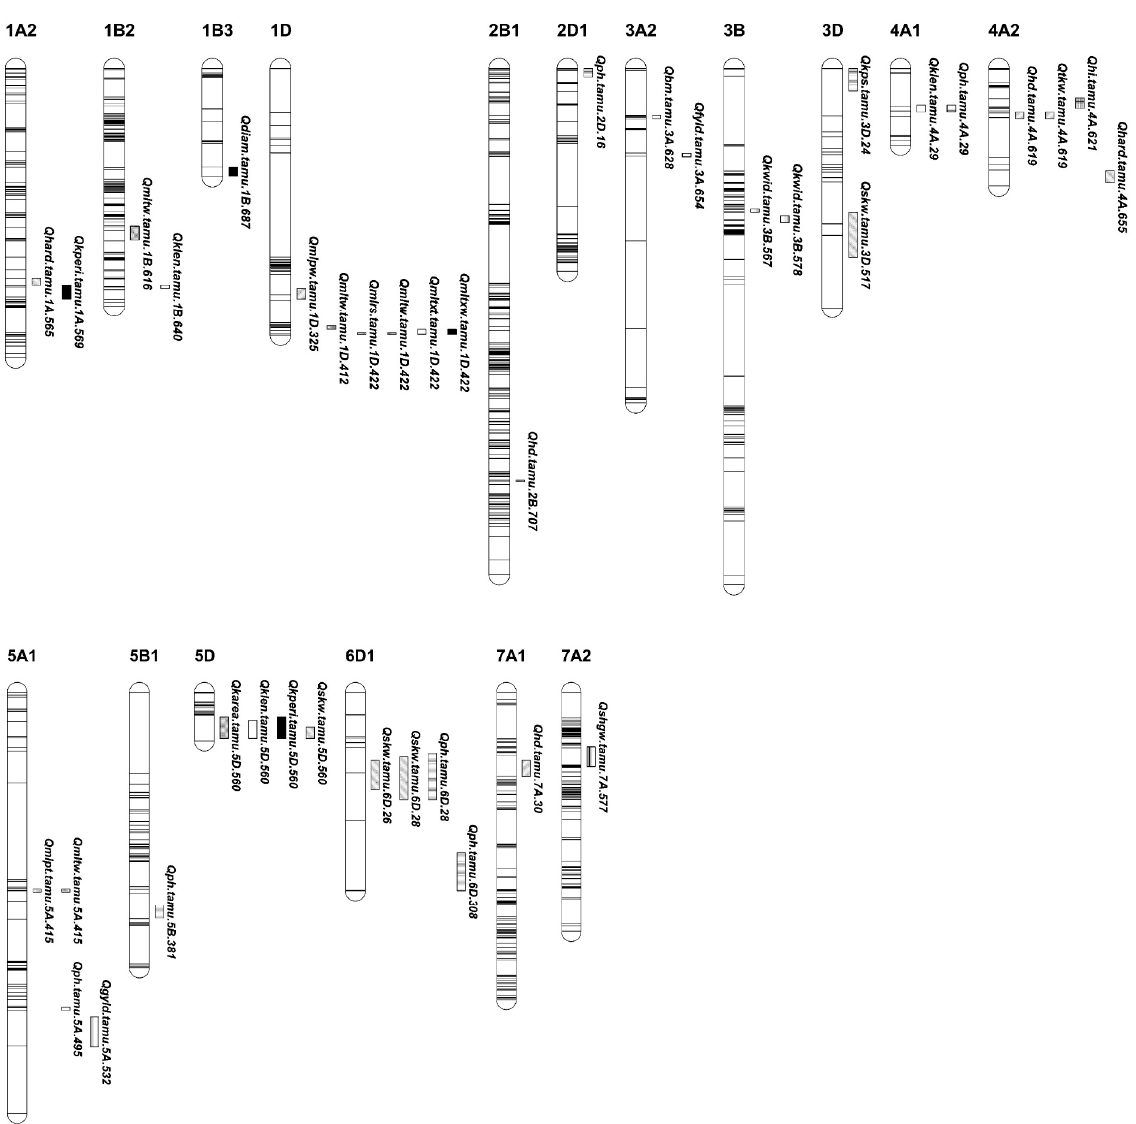
Figure 1. Genetic maps highlighting the positions of QTLs for end-use quality, agronomical, yield components, and kernel-related traits from the individual (IE), across multiple (MET) and combined BLUPs of the environments (COMB) in TAM 111 × TX05A001822 RIL population. Horizontal stripes inside a chromosome or linkage group represent the markers. Traits: hardness index (HARD), kernel diameter (DIAM), single kernel weight (SKW), flour yield (FYLD), flour protein at 14% moisture (PROT), flour ash at 14% moisture (ASH), midline peak time (MLPT), midline peak value (MLPV), midline peak width (MLPW), midline right slope (MLRS), midline tail width MLTW, midline time X time (MLTXT), midline time X width (MLTXW), grain yield (YLD), plant height (PH), days to heading in Julian Calendar from 1 January (HD), dry biomass from hand harvested 0.5 m long inner row sample (BM), grain weight from BM as hand harvested dry grain weight (BMYLD), harvest index (HI), kernels per spike (KPS), spikes per square meter (SPM), thousand kernel weight (TKW), single-head dry weight (SHDW), single-head dry grain weight (SHGW), kernel area (KAREA), kernel length (KLEN), kernel perimeter (KPERI), and kernel width (KWID). The designation of detected QTL was formatted as Qtrait.tamu.chrom.Mb . The bar length under each QTL is the flanking marker intervals in cM.